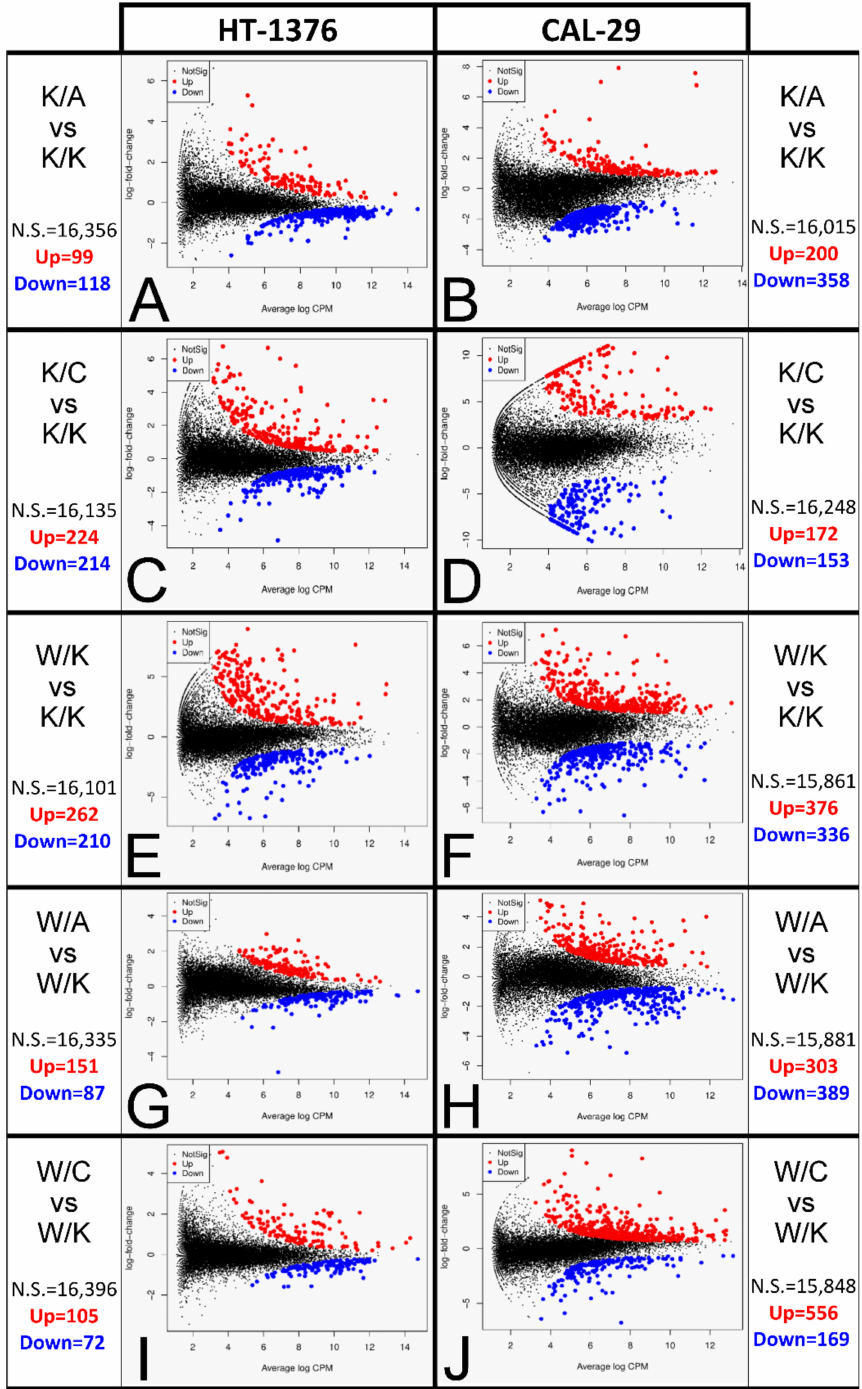
Figure 9. Average genes abundance with log-fold change. ( A , B ) K/A vs. K/K. ( C , D ) K/C vs. K/K. ( E , F ) W/K vs. K/K. ( G , H ) W/A vs. W/K. ( I , J ) W/C vs. W/K. The comparisons are shown in pairs, i.e., A–B, C–D, E–F, etc.; the paired graphs present data of HT-1376 and CAL-29 cells,